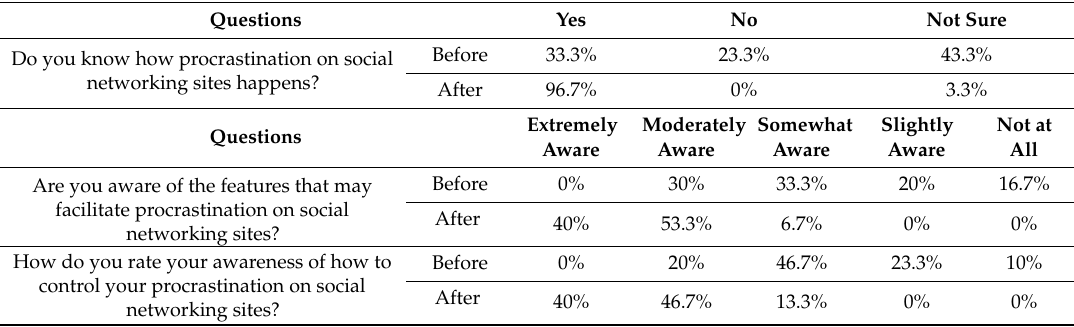
Table 7. Comparison of participants’ awareness before and after using D-Crastinate.